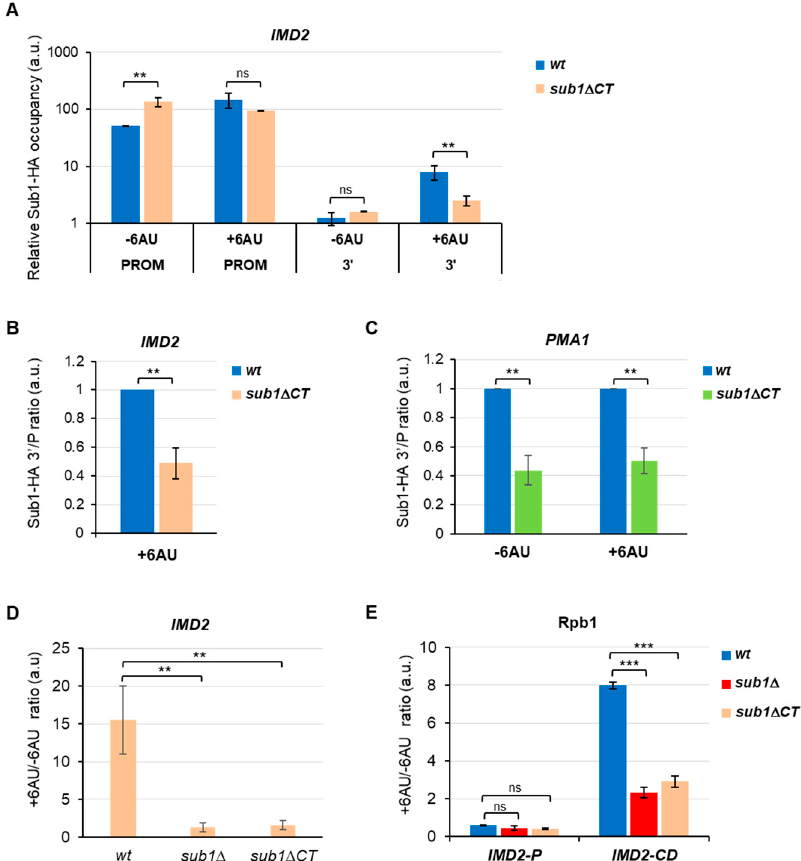
Figure 5. The C-terminal region of Sub1 is required for proper IMD2 expression. ( A ) Sub1-HA relative occupancy at the promoter, as well as 3 (cid:48) regions of the IMD2 gene in wt and sub1 ∆ CT cells were analyzed by ChIP in the presence or absence of 100 µ g/mL 6AU. Data represented in the graph were calculated and plotted as shown in Figure 4A; a logarithmic scale has been used to highlight the association defects at the 3 (cid:48) -end regions compared to the promoter region of the IMD2 gene. ( B ) The 3 (cid:48) /P association ratio for IMD2 . ( C ) The 3 (cid:48) /P association ratio for PMA1 gene in the presence or absence of 100 µ g/mL 6AU. ( D ) RT-qPCR to analyze IMD2 gene expression; total RNA was purified from wt , sub1 ∆ , and sub1 ∆ CT cells grown in SC-URA, with or without 100 µ g/mL 6AU, with synthesized cDNA and used qPCR reactions. The values from the reaction with IMD2 mRNA were normalized to 18S rRNA, and the +6AU/-6AU ratio for wt , sub1 ∆ , and sub1 ∆ CT cells was calculated and graphed. ( E ) Relative Rpb1 occupancy, at the promoter and coding regions of the IMD2 gene, was examined by ChIP in wt , sub1 ∆ , and sub1 ∆ CT cells before and after 6AU (100 µ g/mL) treatment. The Rpb1 binding (promoter, P, and coding regions, CD) was measured in all the cells, as shown in ( A ), and then, the +6AU/-6AU ratio was estimated and represented. Error bars are standard deviations. Statistically significant levels are shown where ns = non-significant, ** = p < 0.01, *** = p <